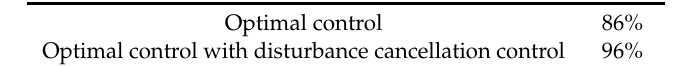
Table 6. Levitation probability when vibrating frames by the random disturbance ( θ = 13 ◦